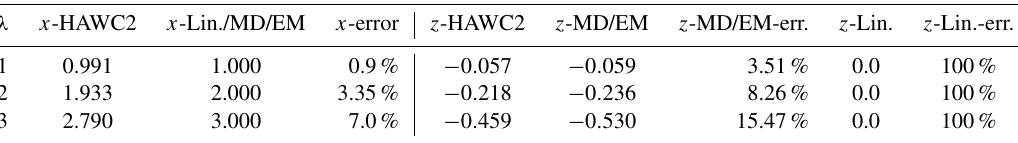
Figure 8. Straight-beam x and z (axial) positions for λ = 2 (a) and λ = 3 (b) load cases. The positions are shown for HAWC2, linear ROM, MD and EM corrections. Table 3. Straight-beam lateral ( x ) and axial ( z ) tip deflection results for HAWC2, linear model, MD and EM corrections together with the errors in the models compared to